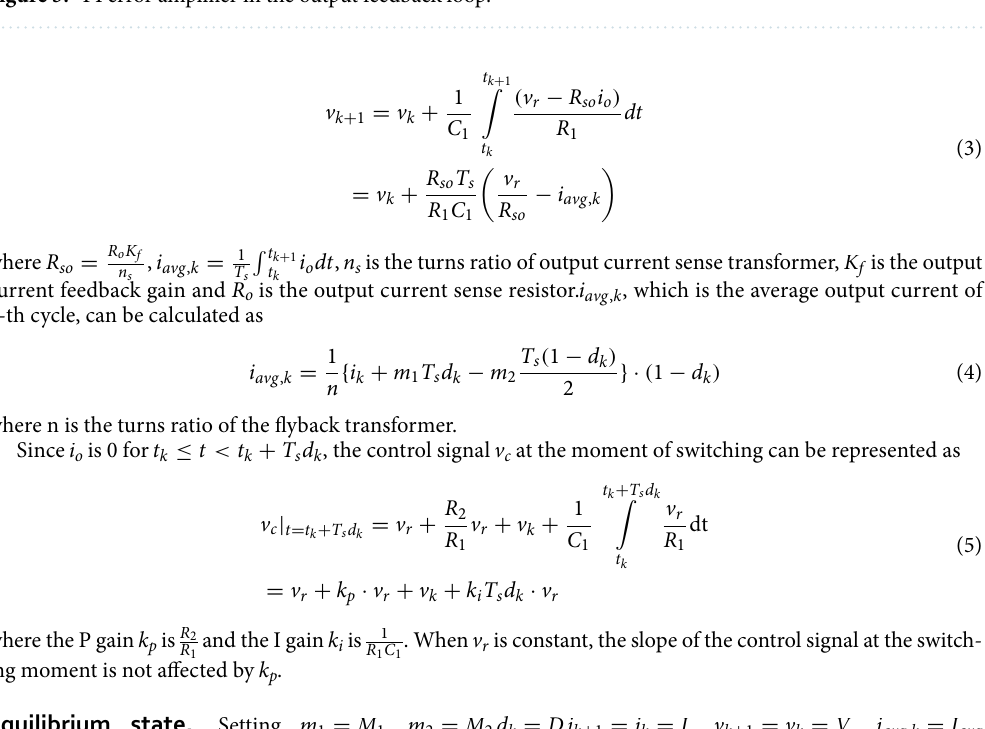
Figure 3. PI error amplifier in the output feedback